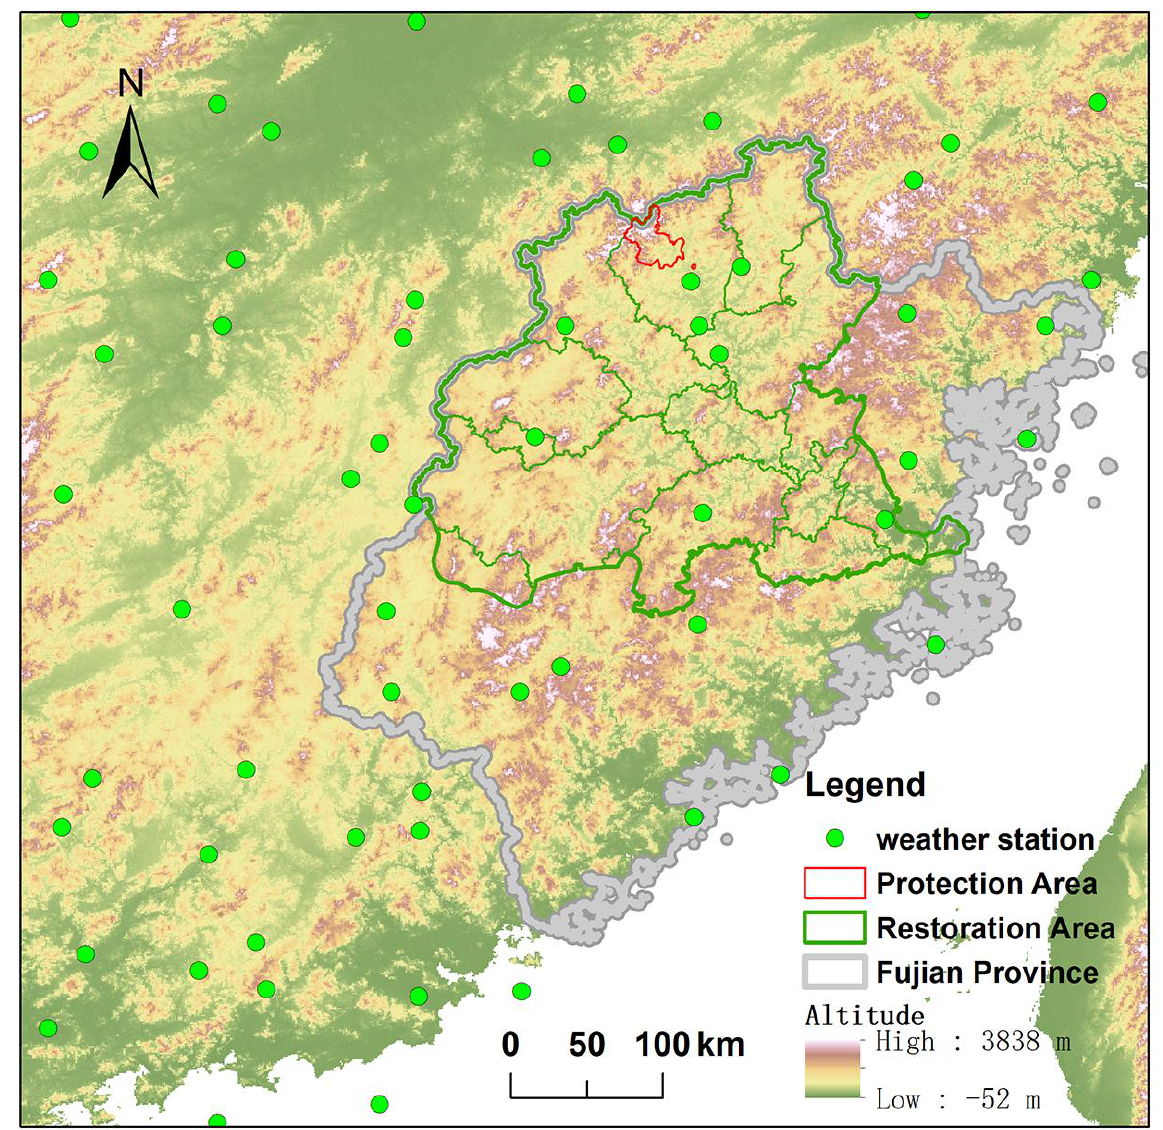
Figure 1. The site of the research area.